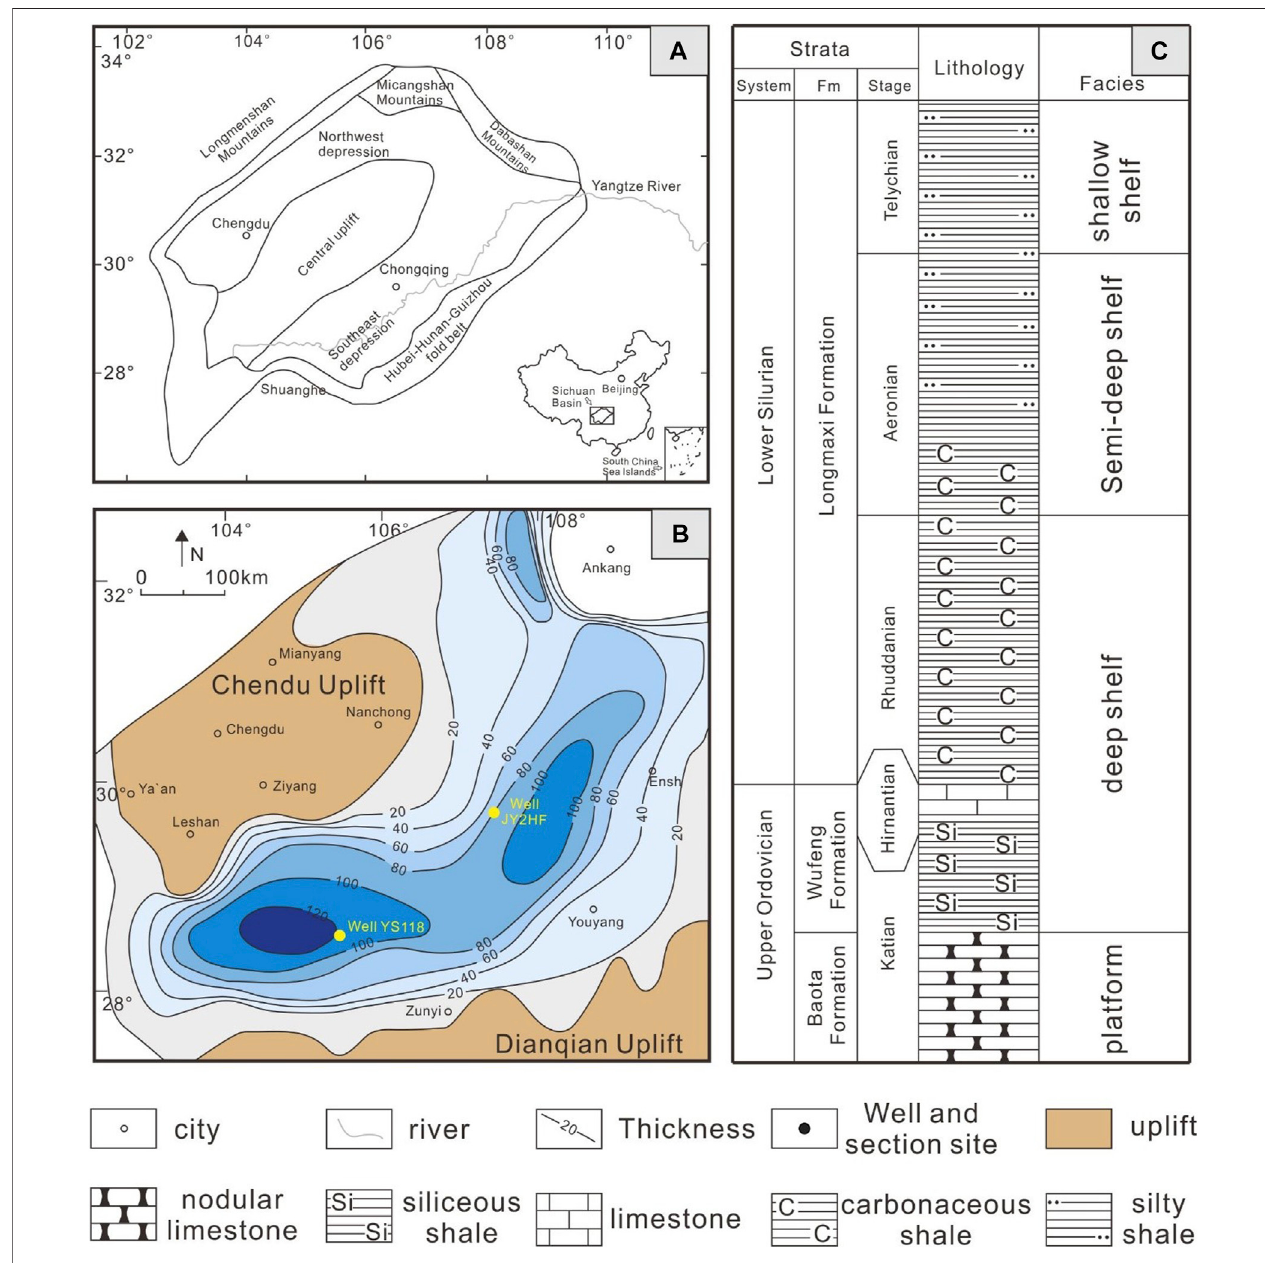
FIGURE 1 | (A) The geographical location of the study area, (B) Early Silurian paleogeographic map of the study area (modi fi ed from Wang et al., 2015), (C) Stratigraphic column.